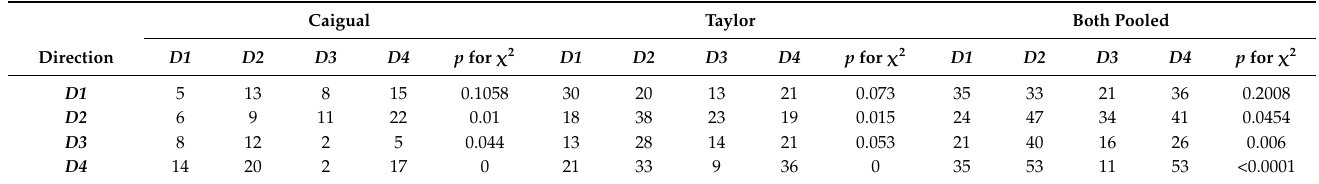
Table 2. Transition matrices from direction sequences ( D1, D2, D3, D4 in Figure 1) and p for row χ 2 with 1:1:1:1 expected.